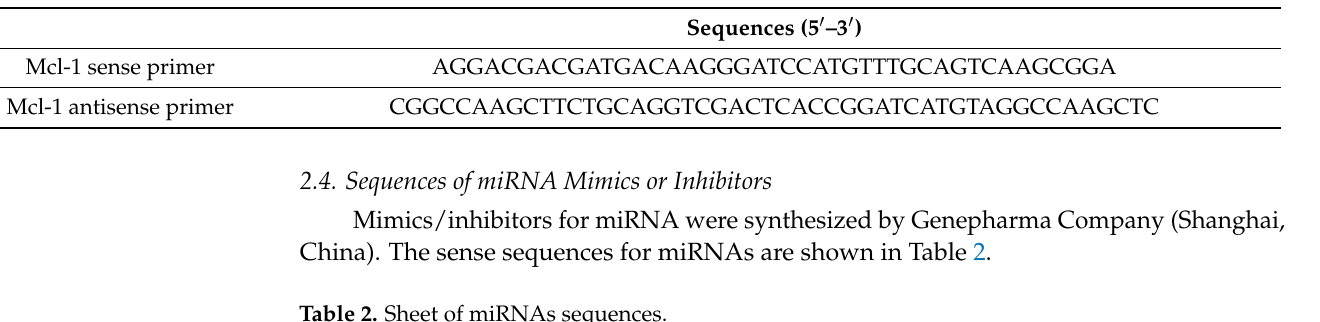
Table 2. Sheet of miRNAs